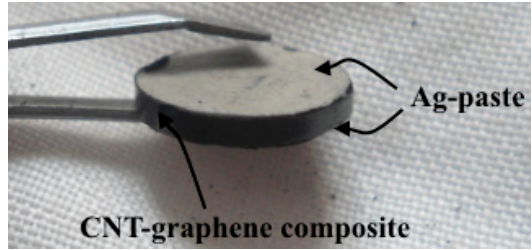
Figure 6. Carbon nanotube (CNT)- graphene composite sample with conductive silver (Ag) paste. Table 1. Specifications of the GW Instek 817 LCR